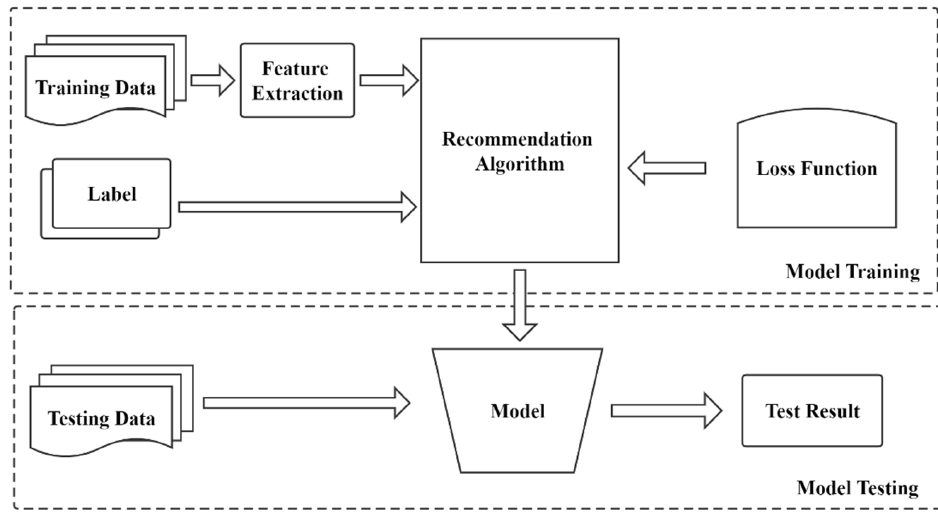
Figure 33. Model-based recommender Figure 33. Model ‐ based recommender system.